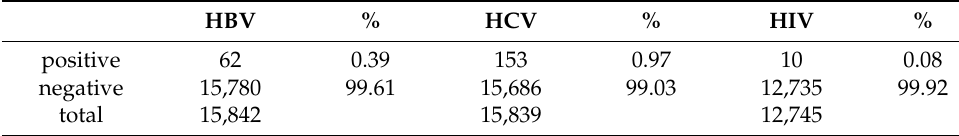
Table 1. Infectious disease test counts and positivity rates.